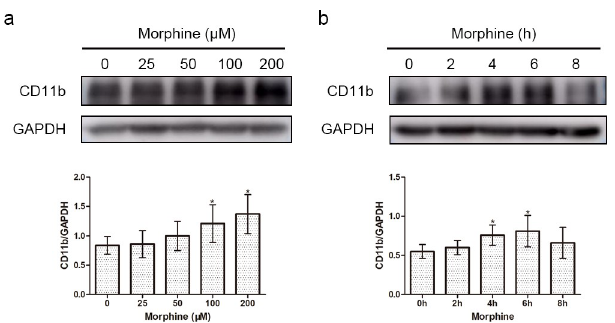
Fig 2. Dose- and time-dependent changes in the expression of CD11b proteins with morphine treatment were analyzed by Western blotting. BV-2 cells were treated with 0, 25, 50, 100, and 200 μ M morphine for 24 h (a) or with 200 μ m morphine for 0, 2, 4, 6 and 8 h (b). GAPDH was used as a loading control. Data are expressed as the means ± SEMs. All data were analyzed using ANOVA. � p < 0.05 compared to the control group.